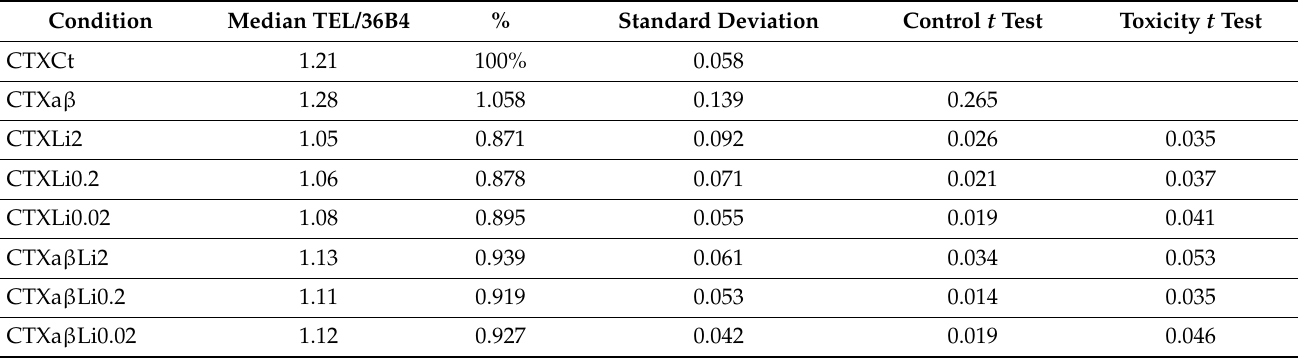
Table A2. TEL/36B4 ratio in